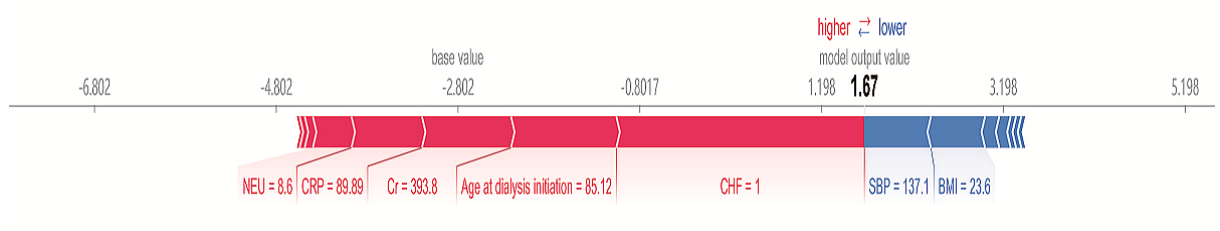
Figure 5. The SHAP value for a single data sample. BMI: body mass index, CHF: congestive heart failure, CRP: C-reactive protein, Cr: creatinine, NEU: neutrophil, SBP: systolic blood